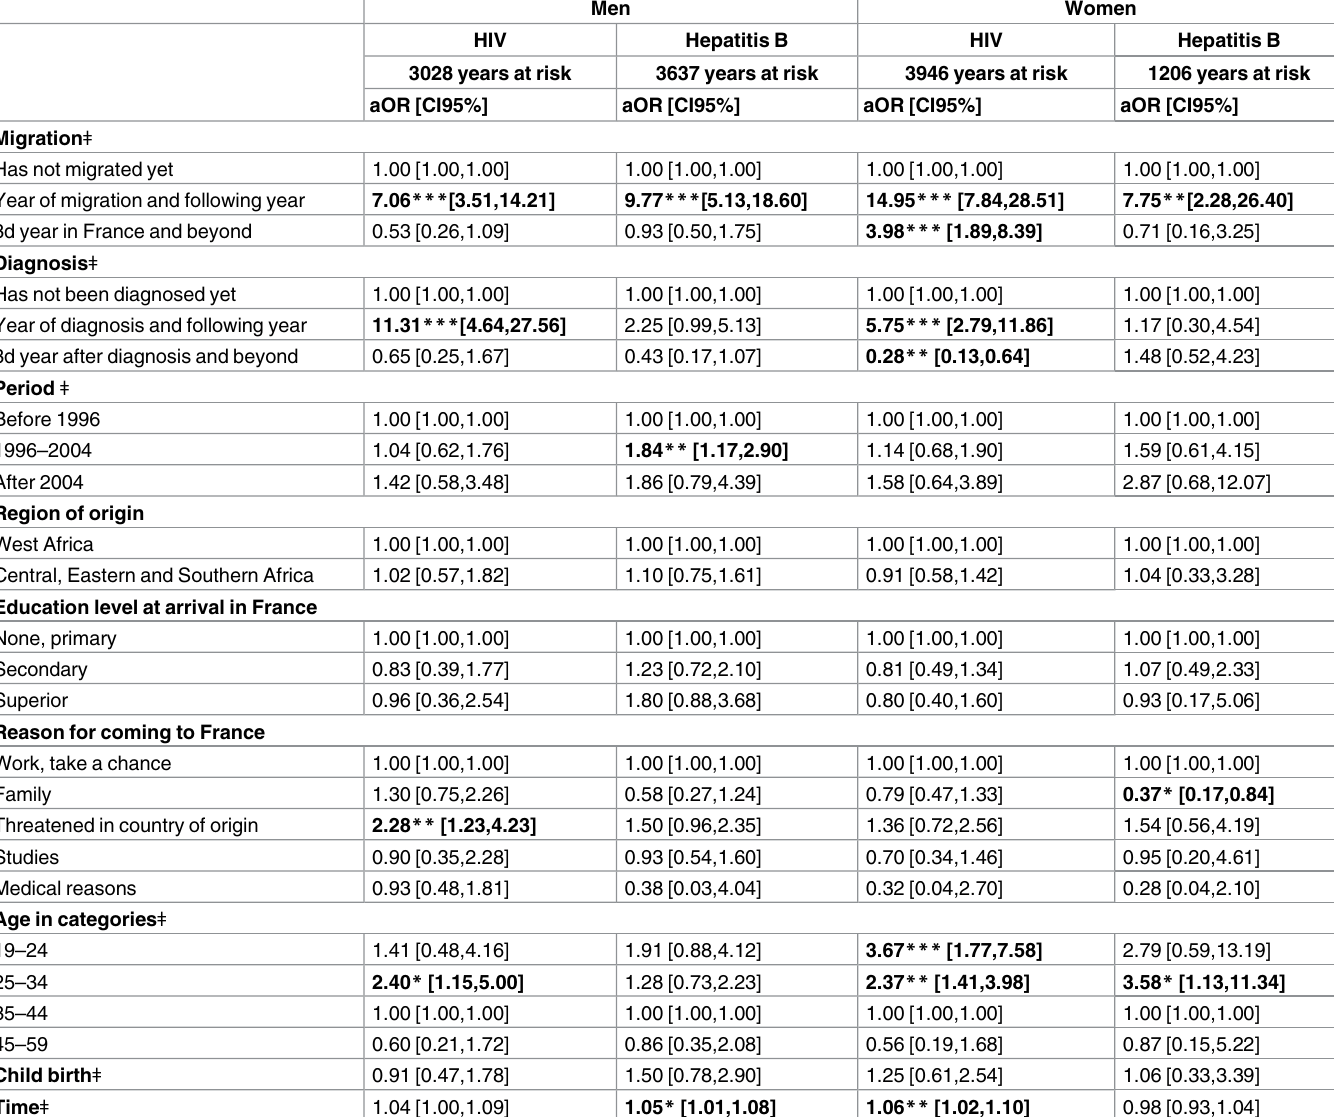
Table 4. Factors associated with transition towards ill-being year by year since 18 yearsof age until data